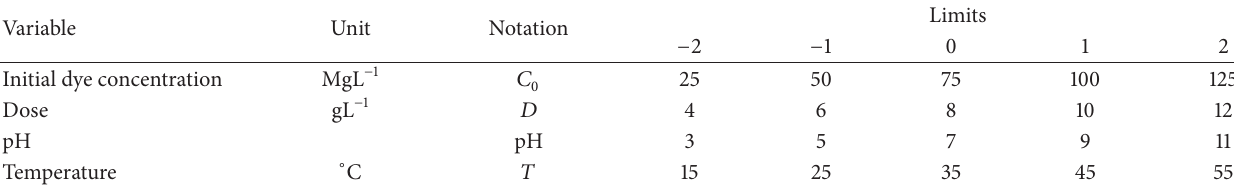
Table 2: Process control variables and their